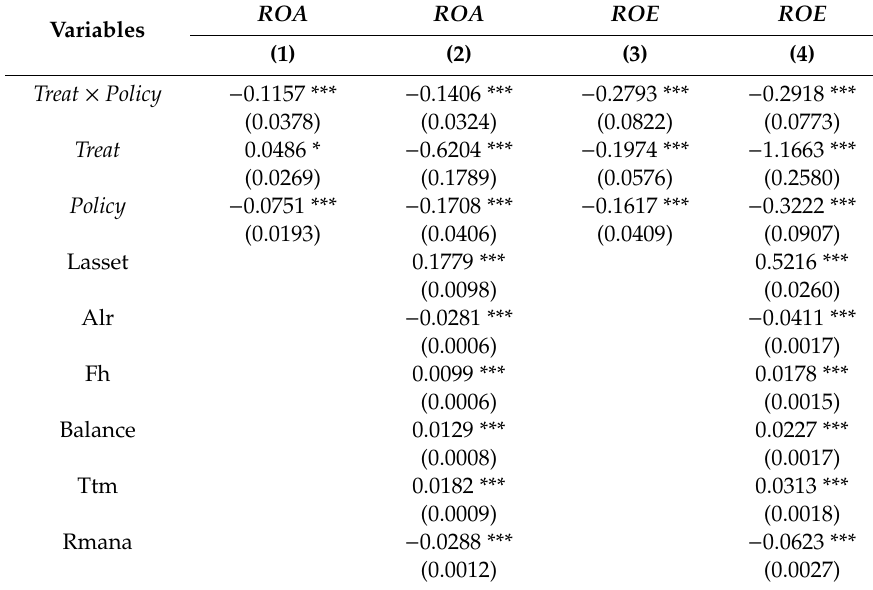
Table 3. The impact of the NEPL on enterprises’ financial